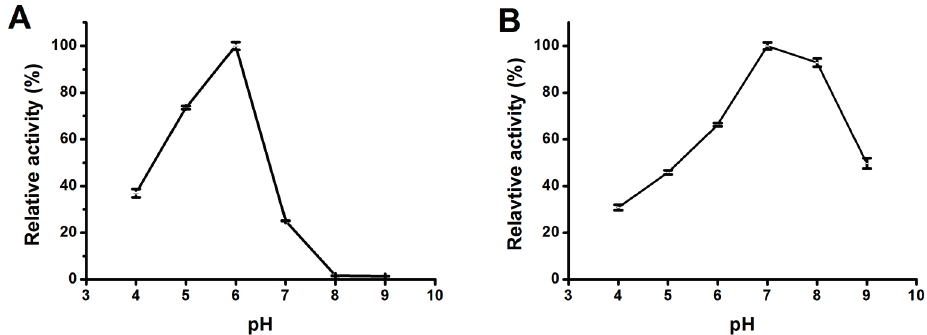
Figure 4. Effect of pH on the activity ( A ); and stability ( B ) of Mg MDL2. Activities are shown as percentages of the maximum activity. Values are means ± S.D. from